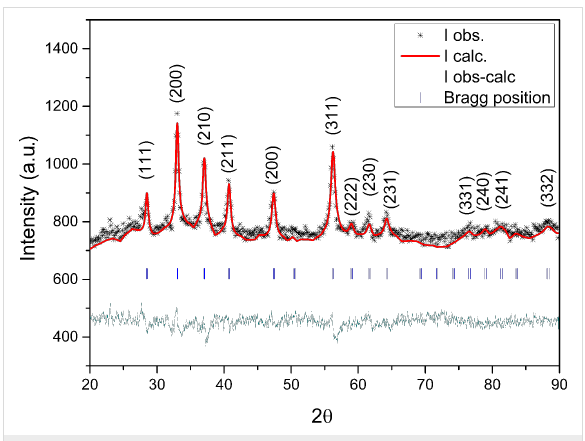
Figure 1: XRD pattern of the nanoparticles, indicating that pyrite was the only crystalline phase resulting from the synthesis. Rietveld analysis of the reflection broadening gave an average crystallite size of 20 nm.